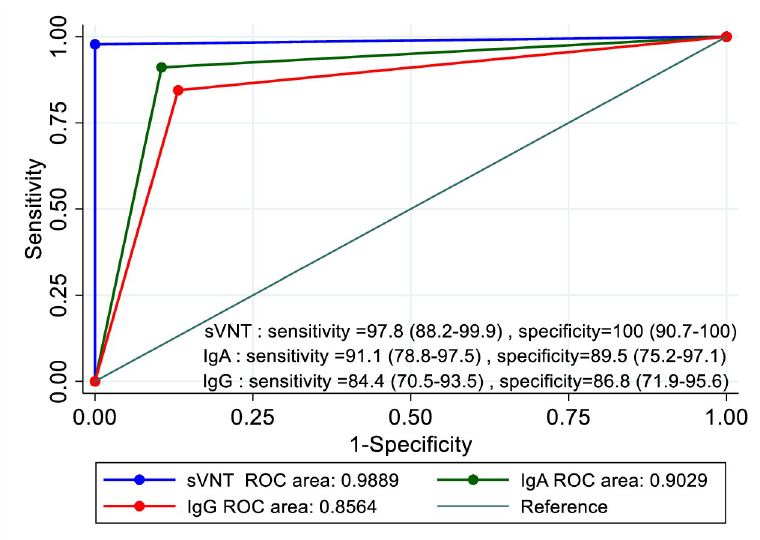
Fig 1. Comparison of Area under the ROC curve (AUC) between sVNT, IgA and IgG tests (PCR-confirmed COVID-19 patients = 45, negative control serum = 38). The correlation is modest between the level of %inhibition by sVNT and the ratio of semi-quantitative measurement of IgA and IgG (R-squared (r2) = 0.386 and 0.343, respectively) by Random-effects generalized least-squares regression.